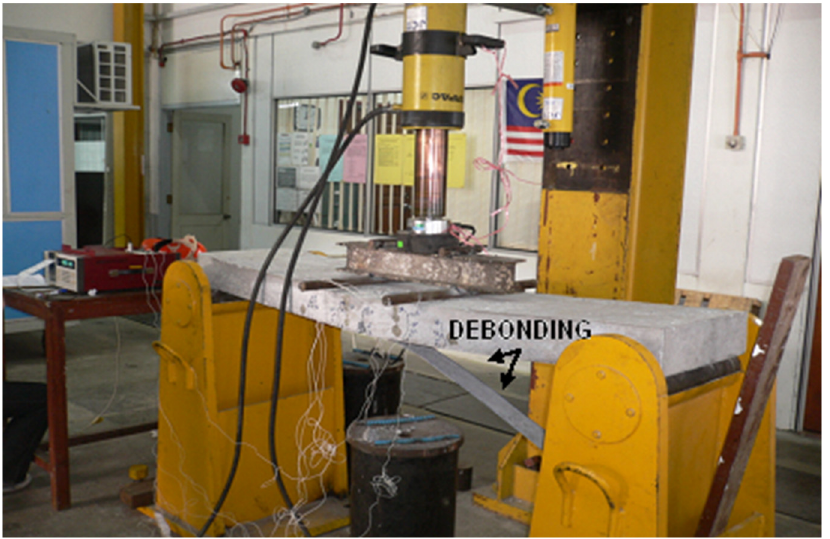
Figure 9. De-bonding mechanism of concrete/CFRP interfaces under four-point bending test.